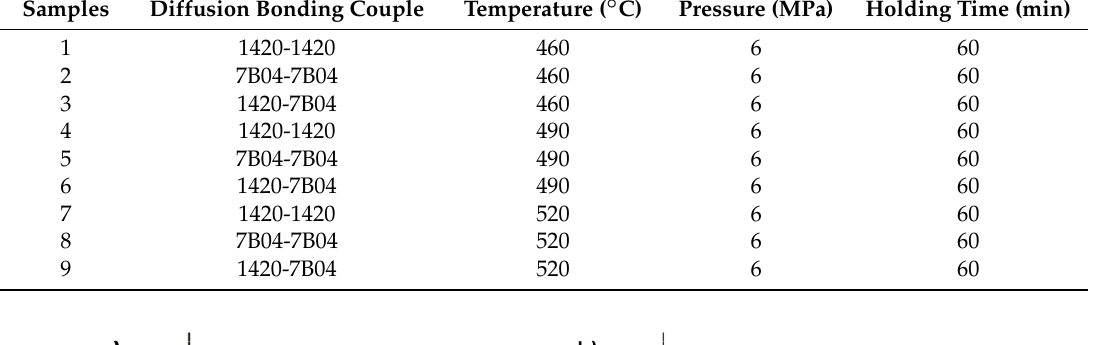
Table 2. Diffusion bonding parameters and bonding couples conducted in the present study.